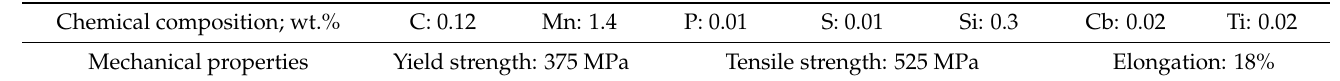
Table 1. Chemical composition and mechanical properties of API-2H-Grade